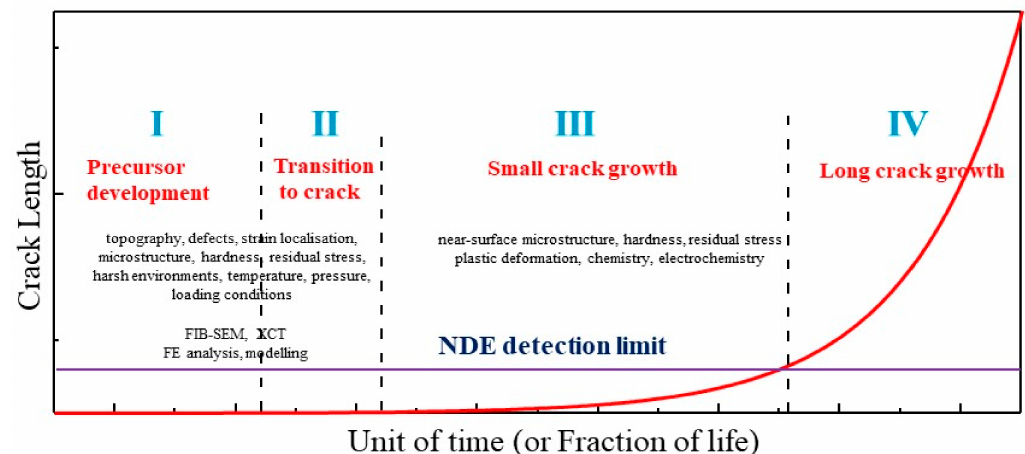
Figure 1. Schematic depiction of the evolution of crack size as interlinked stages of development.